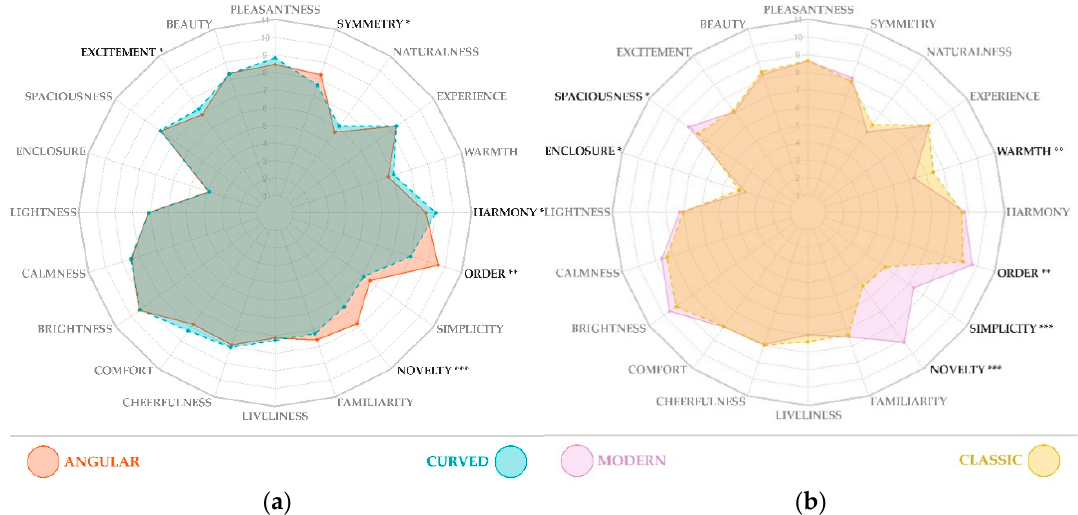
Figure 4. Display of participants’ responses to the bipolar dimensions of the affective and spatial experience questionnaire. The scales were converted from ( − 5, 0, 5) to (1–11) for analysis and display purposes. Individual scores were calculated based on averaging responses to every two rooms presenting the same condition, and the charts’ scores represent means on each of the dimensions. Plot ( a ) displays results for contour conditions (angular vs. curved), and plot ( b ) shows results of style conditions (modern vs. curved). Significant dimensions are marked with asterisks (*** for p < 0.001, ** for p < 0.01, and * for p < 0.05) and are written in black color for ease of reference. These graphics were created in R Studio, using package fmsb (Minato Nakazawa, 2021, Available on https://cran.r-project.org/web/packages/fmsb/index.html).